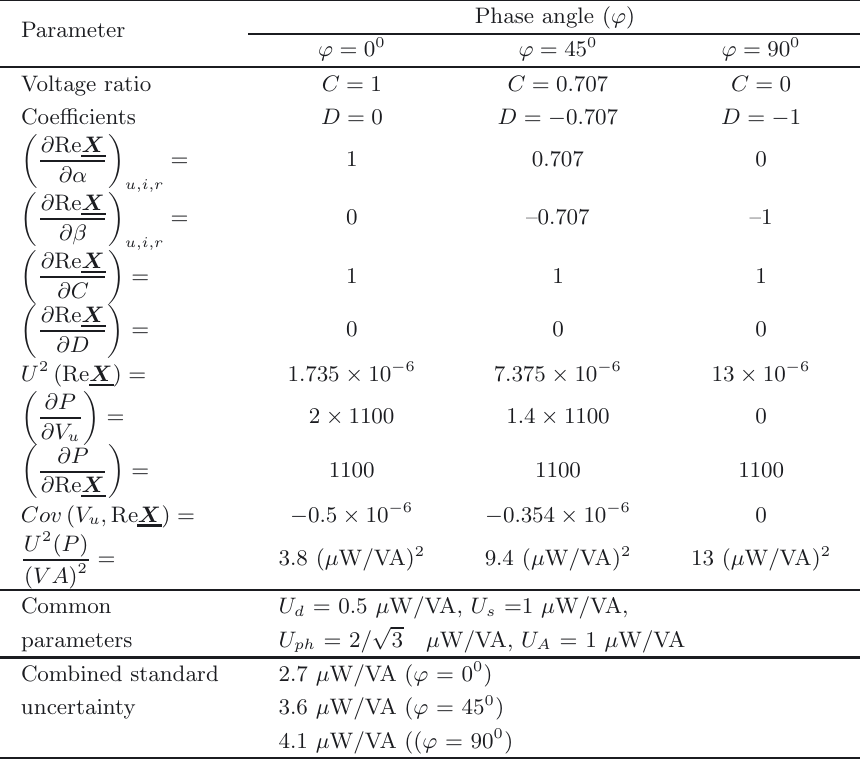
Table 1. Summary of the uncertainty budget.